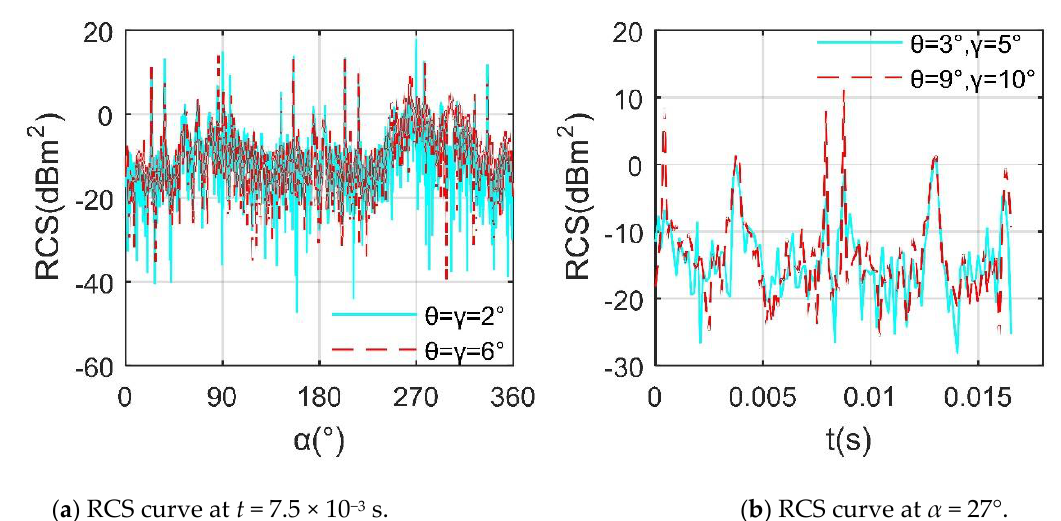
Figure 15. RCS of the helicopter at various attitude angles, f RH = 10 GHz, n r1 = n r2 = 1200 r/min, β = 0°, A df = A dr = 7°, RCS unit: dBm 2 .